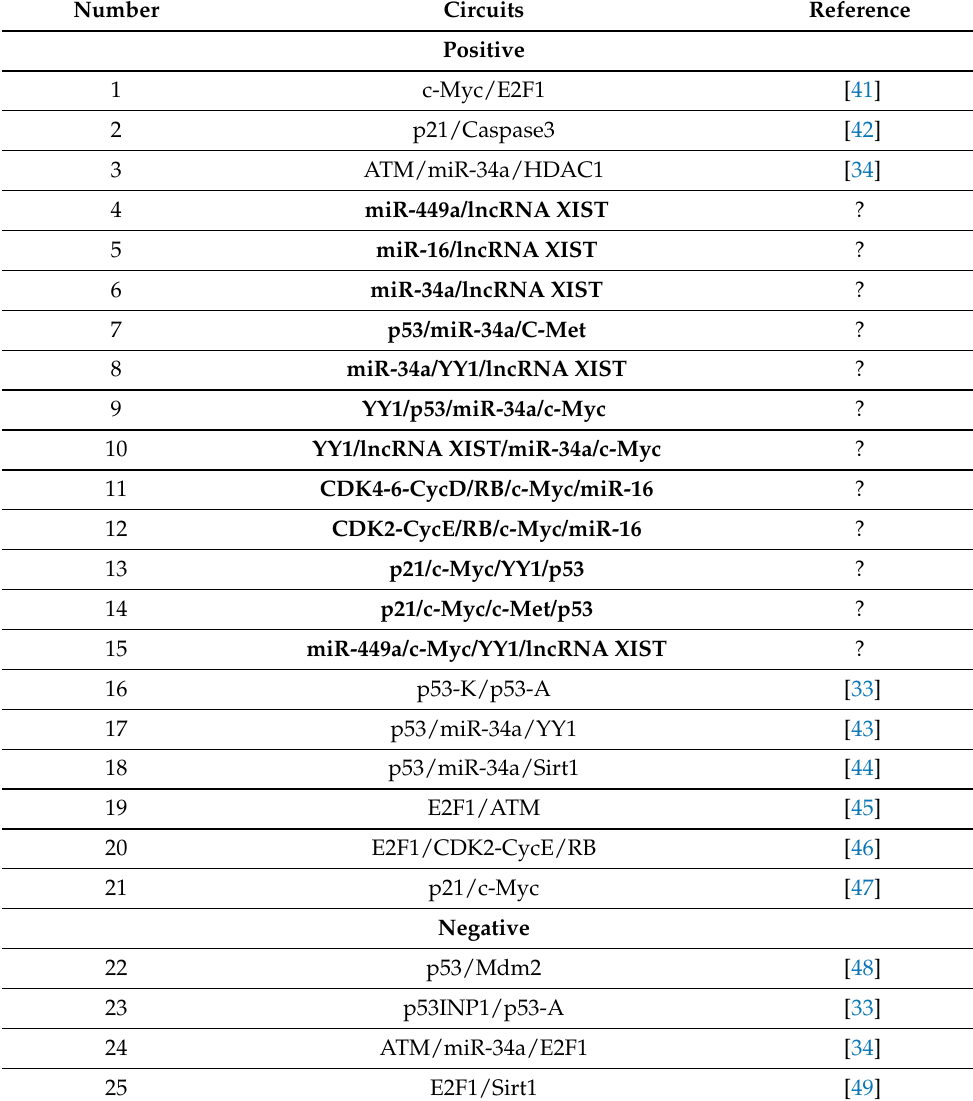
Table 2. Functional circuits in the network and experimental observations. Circuits for which no experimental data were found are indicated by question marks (?) and highlighted in bold fonts. Number Circuits